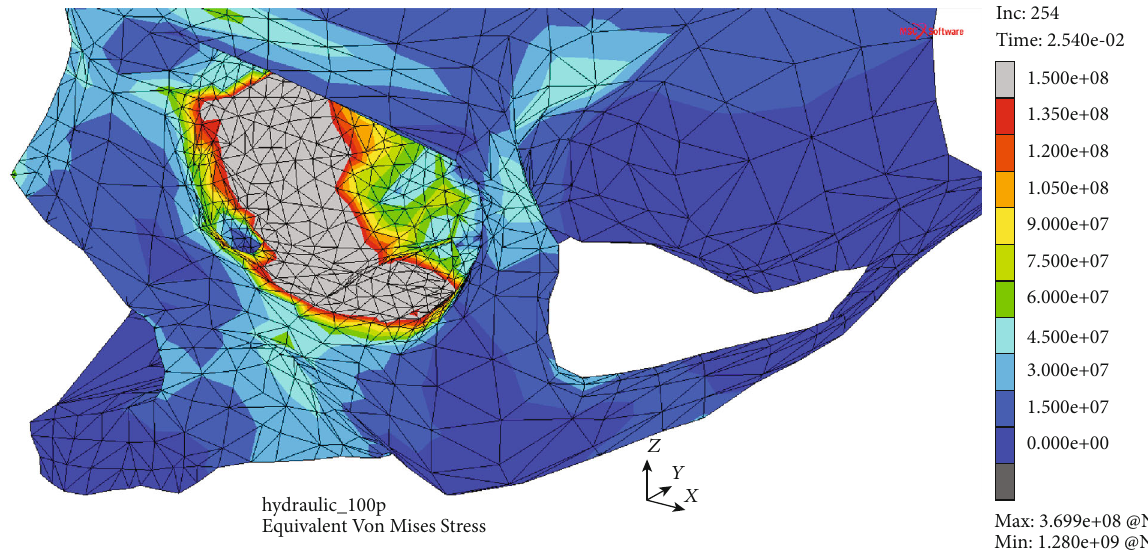
Figure 7: H-M-H stress distribution (Pa) without the deformation within the analyzed thin shell skull part during time t = 25 : 4ms (MOBOSE).